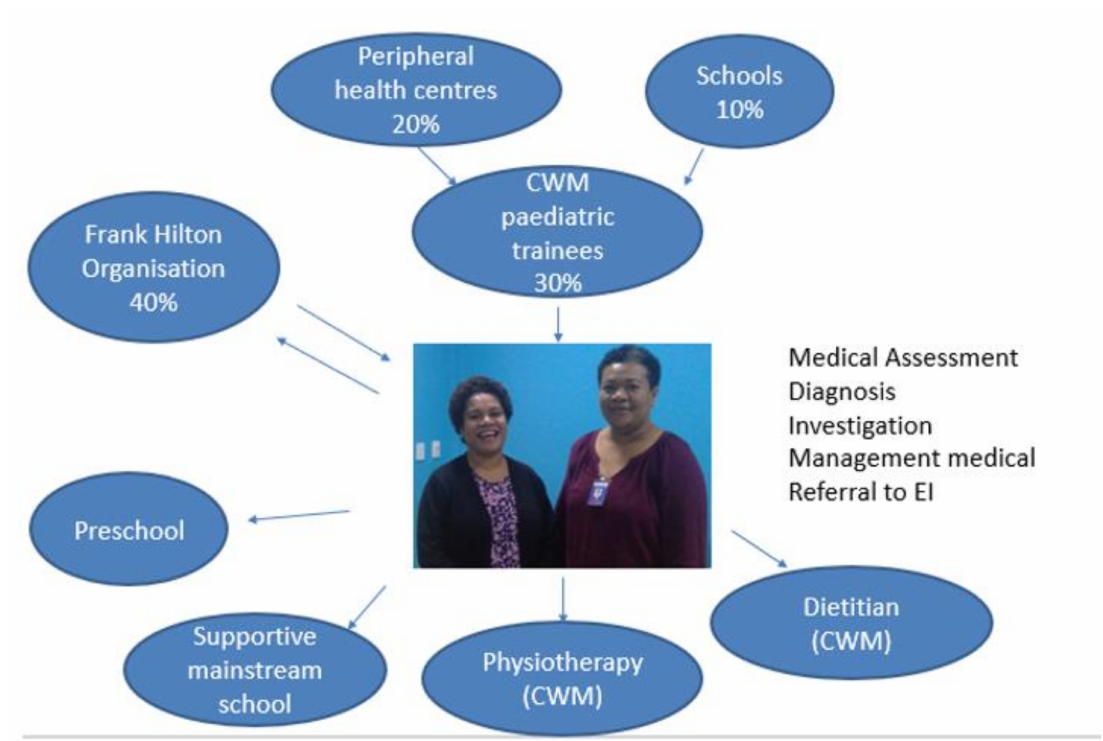
Figure 3. Intake and Referral Pathways to developmental paediatric service*CWM = Colonial War Memorial.